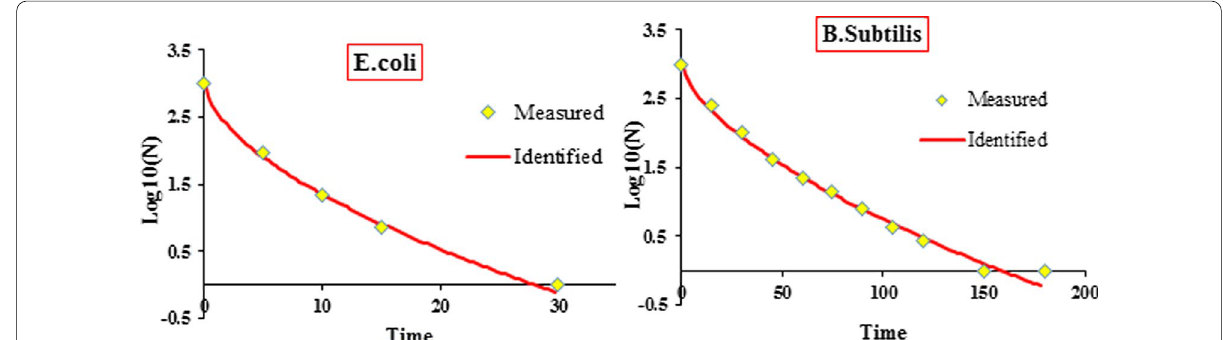
Fig. 9 Experimentally Survival values (Measured) and the model-fit values (Identified) derived from the Weibull model for E. coli and B.